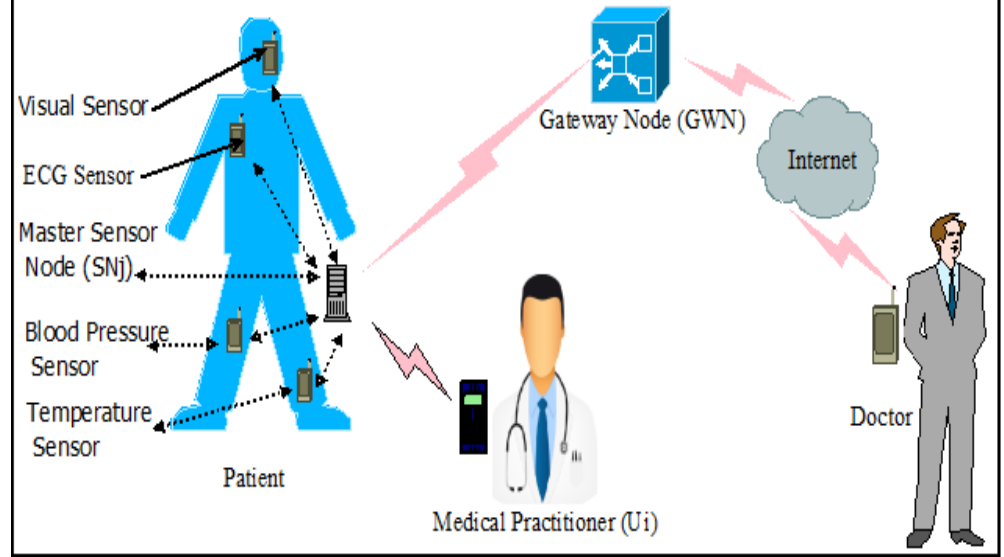
Figure 1. Wireless body area network